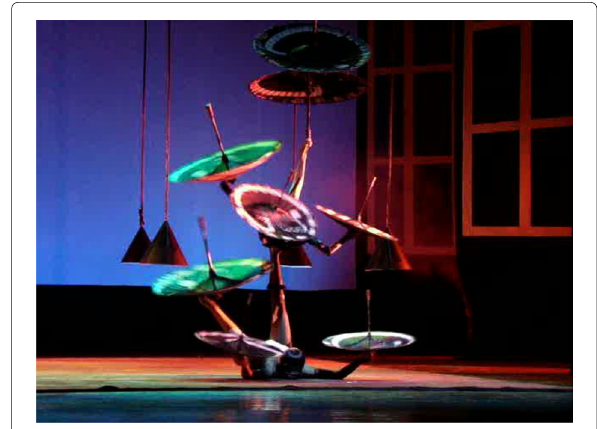
Fig. 1 Don’t bother trying this at home: Chinese acrobats spinning